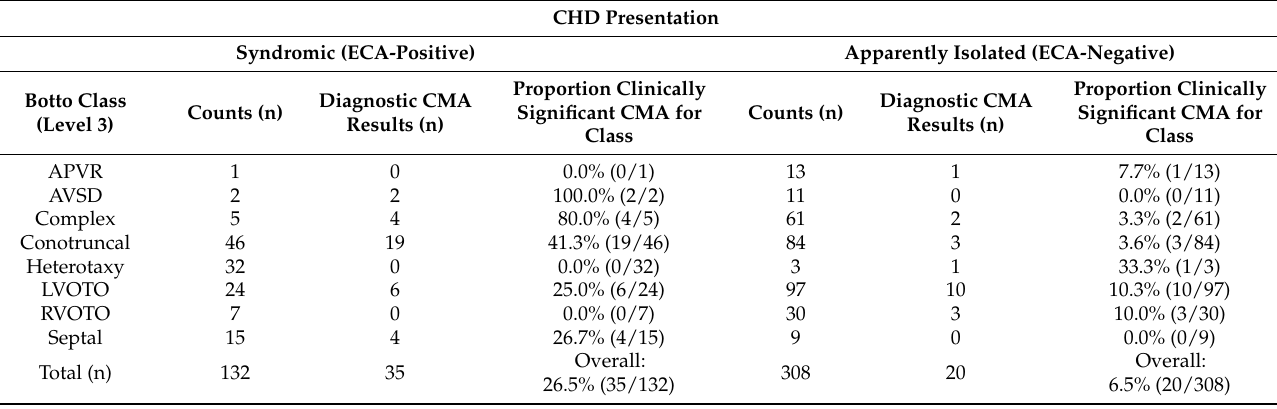
Table 3. Diagnostic yield of chromosomal microarray by Botto class, stratified by extracardiac anomaly status. CHD